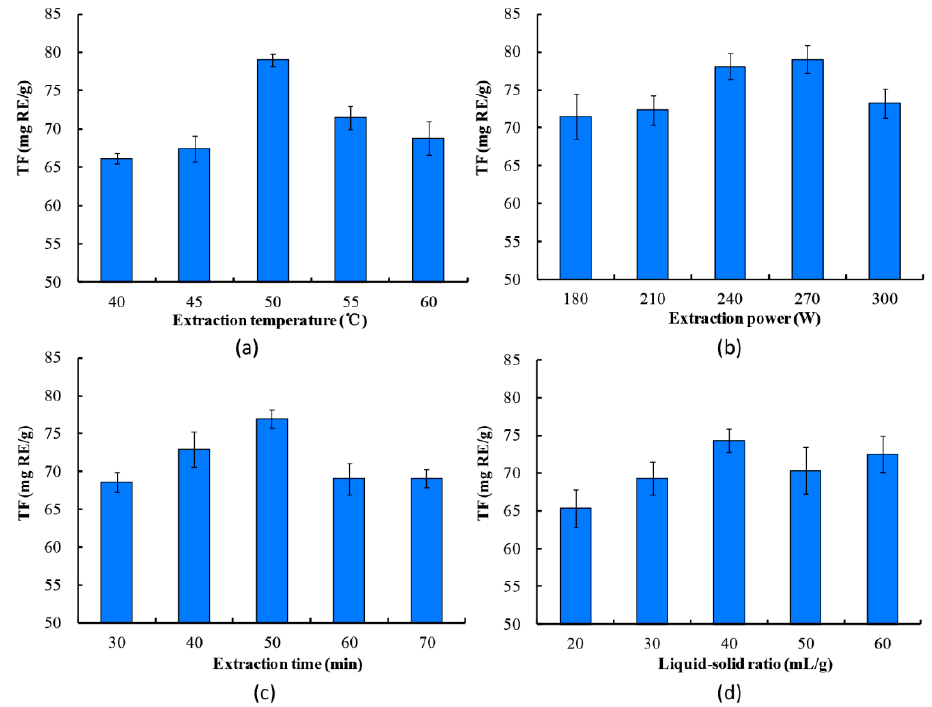
Figure 1. Single-factor effect on the total flavonoids (TF) yield: ( a ) temperature; ( b ) power; ( c ) time; ( d ) liquid-solid ratio.